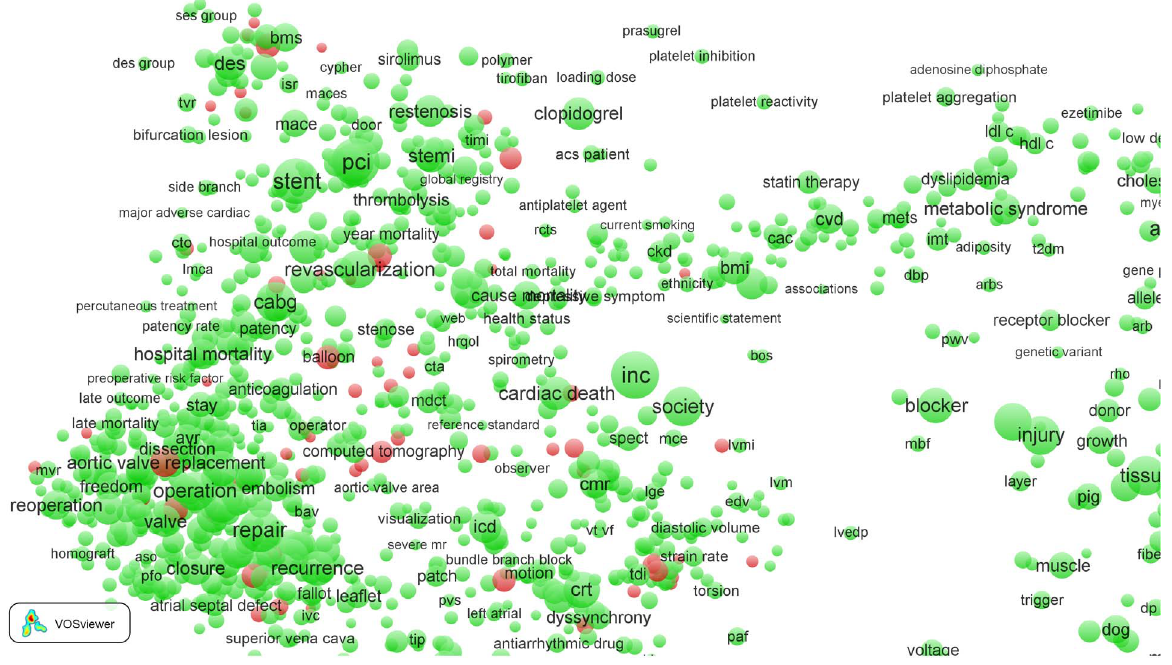
Figure 8. Term map of the Cardiac&cardiovascularsystems field after zooming in into the clinical subfield.